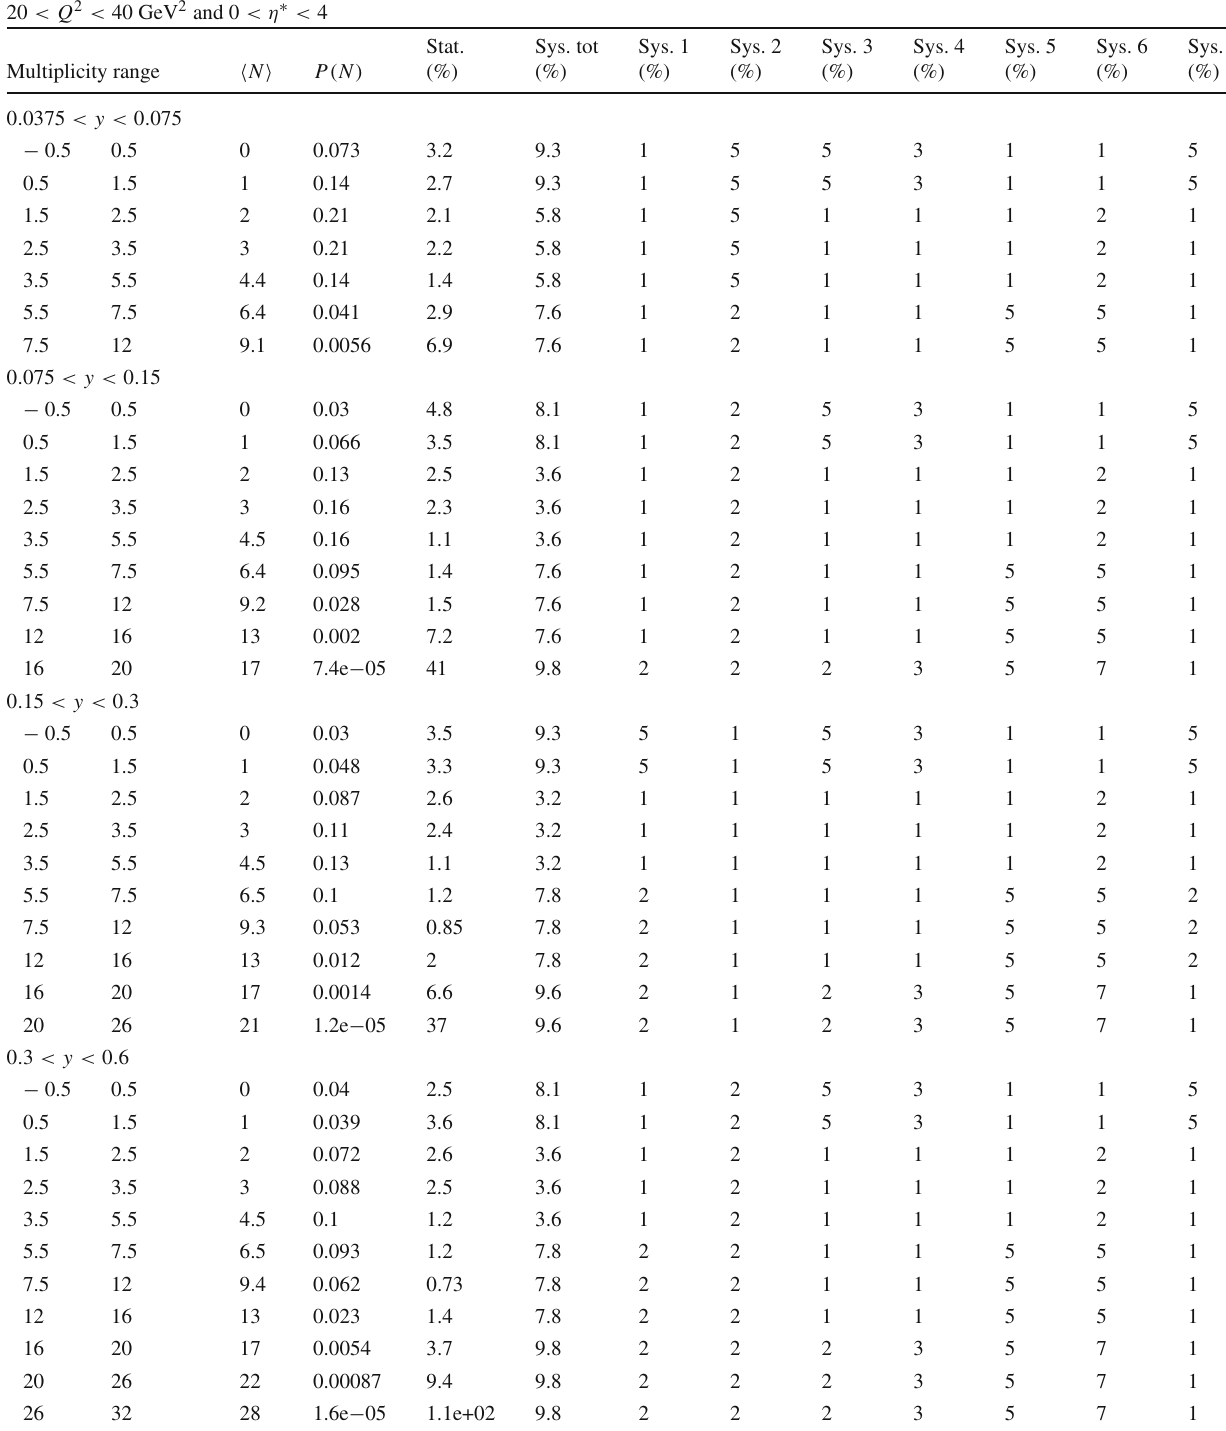
Table 27 Charged particle multiplicity distributions P ( N ) measured √ s = 319GeV with in the ranges of photon virtual- in ep DIS at ity 20 < Q 2 < 40 GeV 2 and charged particle pseudorapidity range Multiplicity distributions in DIS 20 < Q 2 < 40 GeV 2 and 0 < η ∗ <